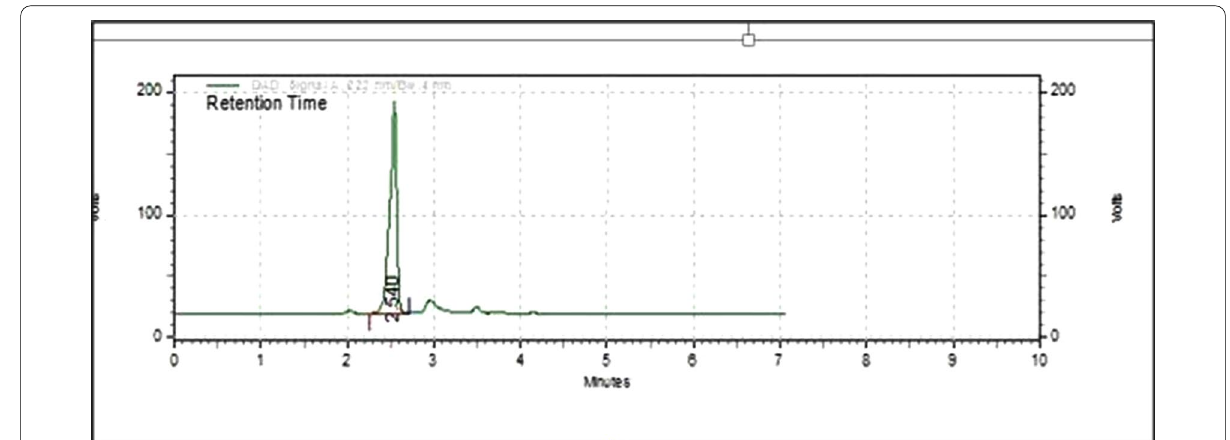
Fig. 3 HPLC chromatogram of empagliflozin at 222.0